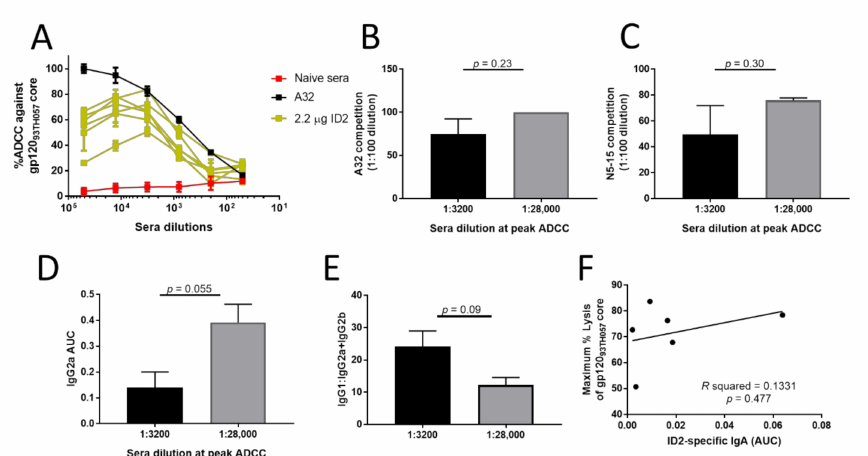
Figure 5. RFADCC capabilities of individual sera from 2.2 µ g ID2 immunized mice. The RFADCC potential of individual sera from ID2 immunized mice was assayed against gp120 93TH057 core coated EGFP-CEN-NKR-CCR5SNAP target cells. ( A ) RFADCC of 2.2 µ g ID2 immunized mice over a broad concentration range of sera dilutions for each individual mouse. ( B ) A32 and ( C ) N5-i5 competition displayed segregated by potency of RFADCC response. ( D ) IgG2a AUC value and ( E ) ratio of IgG1:IgG2a + IgG2b as segregated by potency of RFADCC response. ( F ) Correlation of IgA to RFADCC showing R squared and p calculated using Pearson’s two-tailed correlation. n = 6 mice, individual